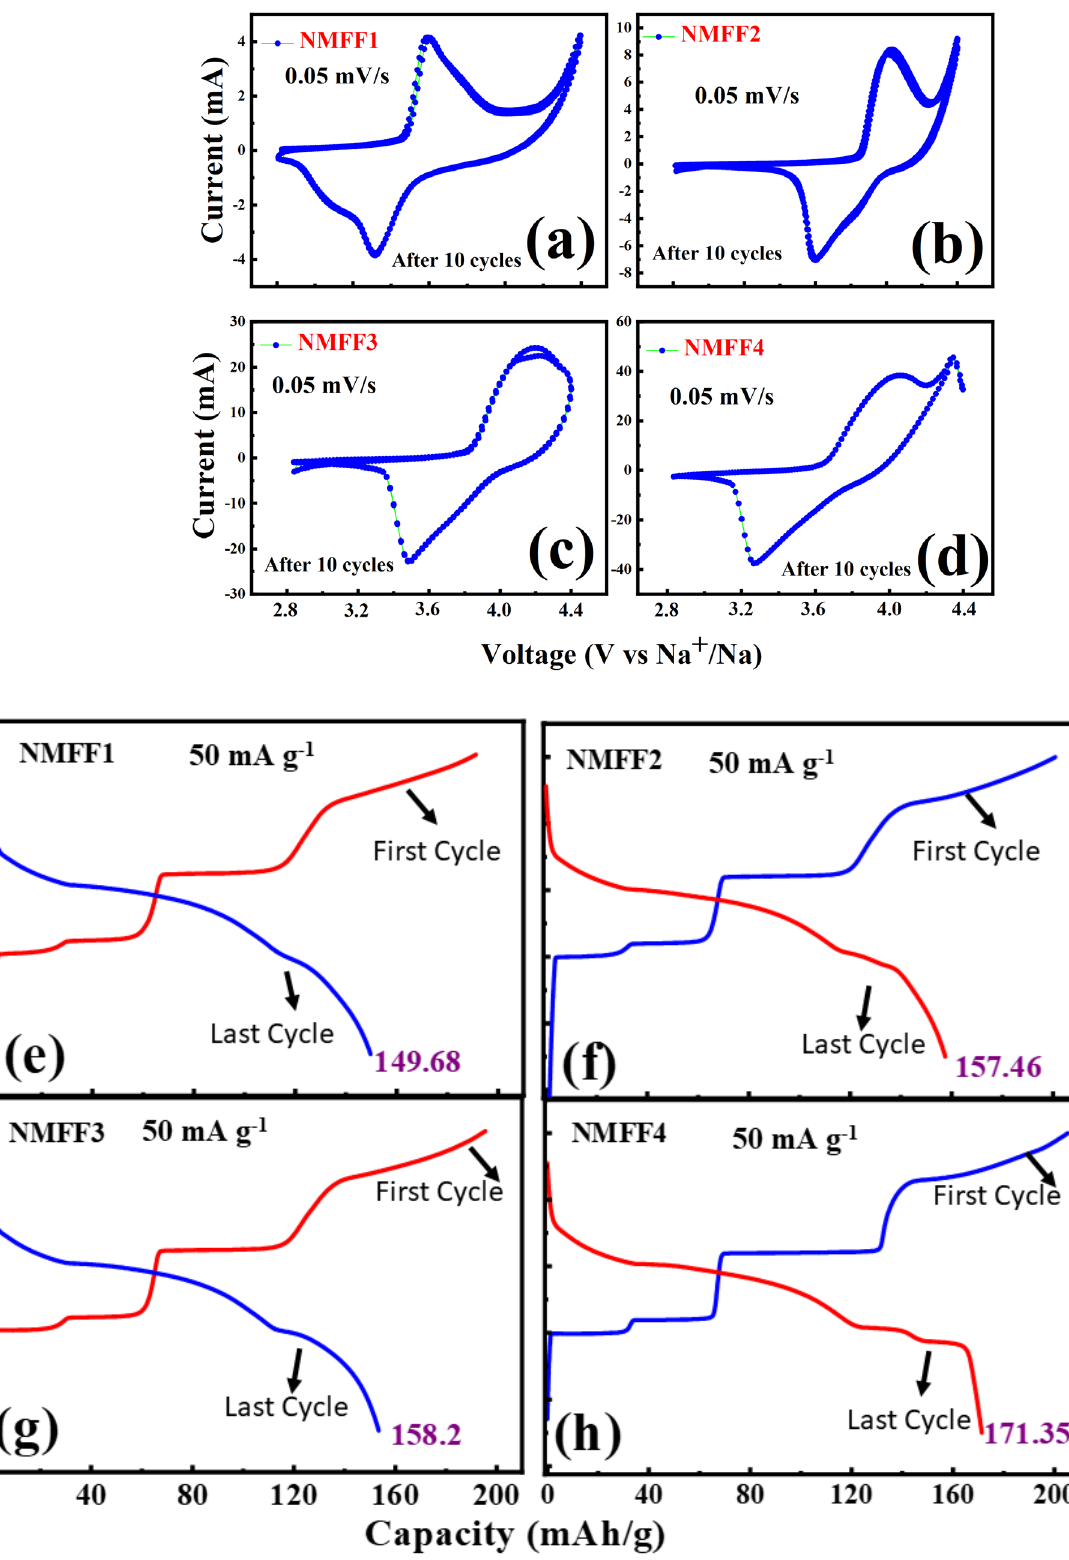
Figure 7. ( a – d ) CV analysis of NMFF1, NMFF2, NMFF3, and NMFF4; ( e – h ) Charge discharge pattern of NMFF1, NMFF2, NMFF3, and NMFF4 at 50 mA g − 1 .